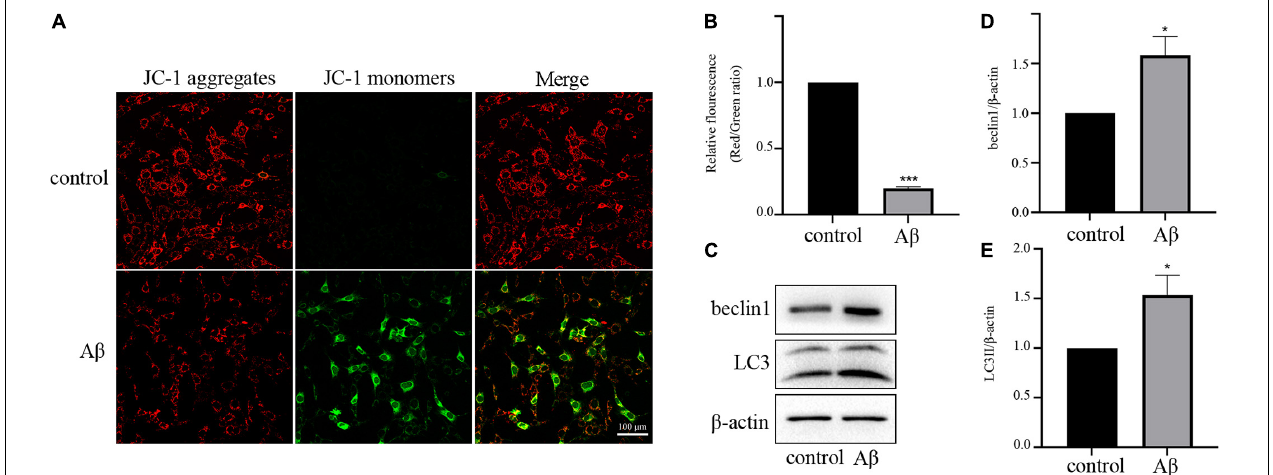
FIGURE 2 | A β treatment disrupts the balance of mitochondria and mitophagy (A) Representative JC-1 staining images of HT-22 cells. (B) Quantitative analysis of the red:green fluorescence intensity. (C) Expression levels of mitophagy-related proteins beclin1 and LC3II. (D) Quantification of beclin1 expression. (E) Quantification of LC3II expression. All experiments were repeated three times. * P < 0.05 vs. control, *** P < 0.001 vs.